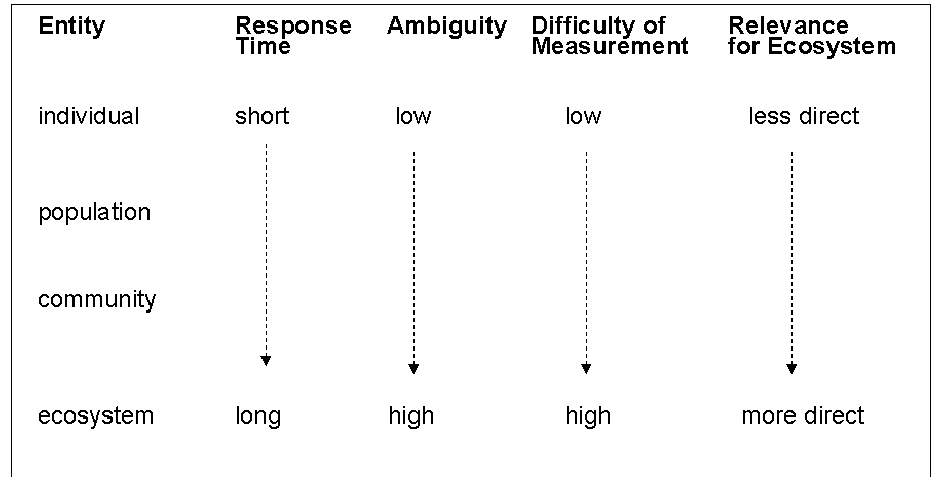
FIGURE 1. Tradeoffs in endpoint selection